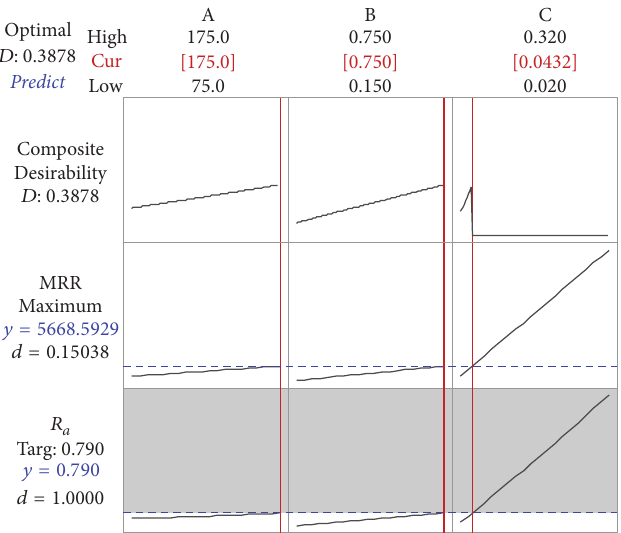
Figure 5: Optimization plot for 𝑅 𝑎 and MRR.